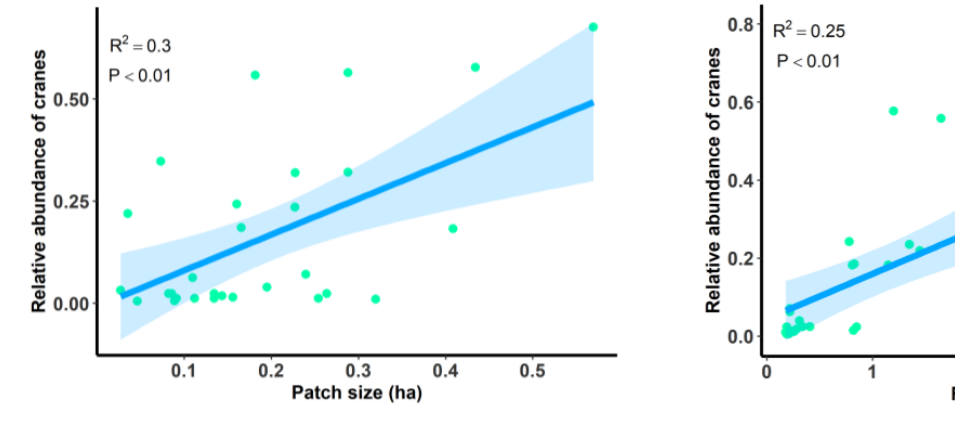
Figure 4. General linear regression between relative abundance of cranes and ( a ) patch size (ha) and ( b ) food biomass (g). (Blue areas represent 95% confidence intervals).